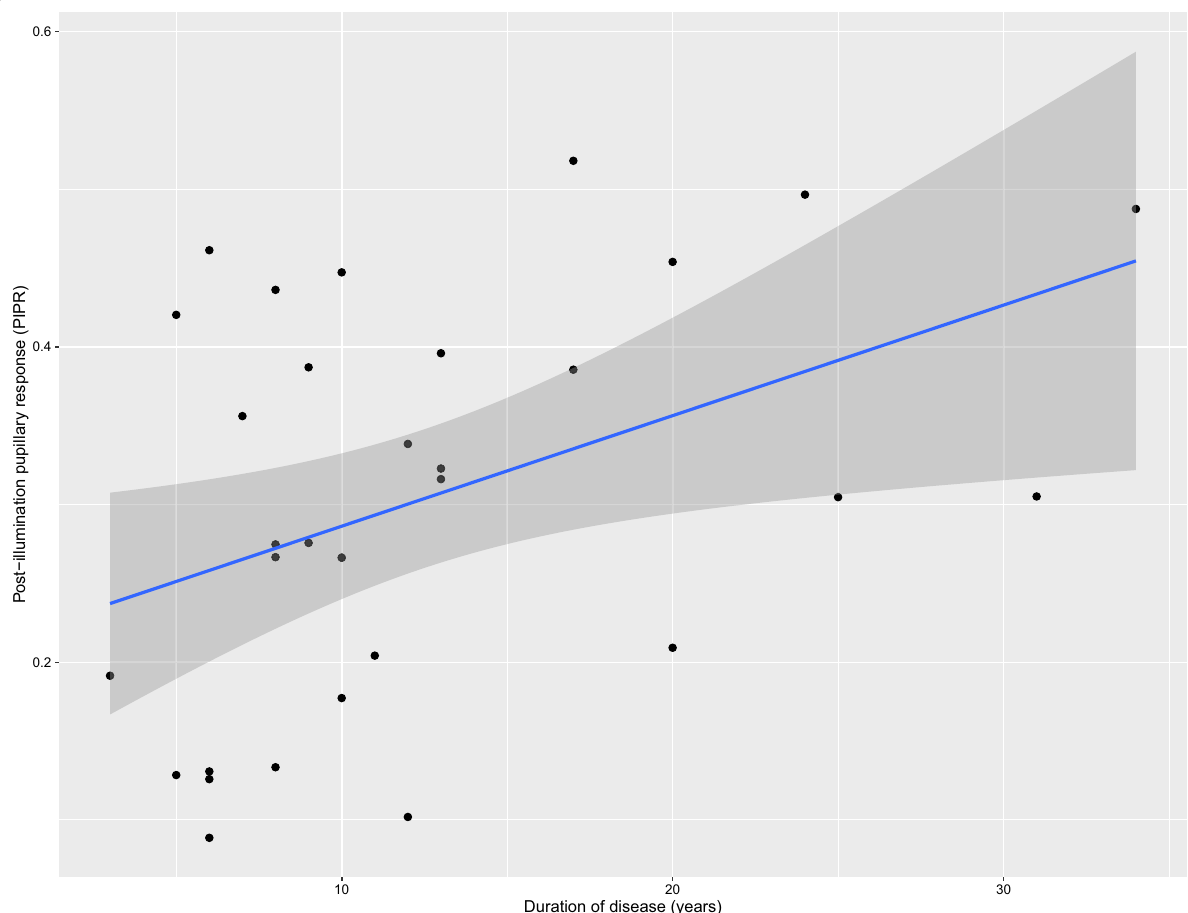
Fig. 2 The post‑illumination pupillary response to blue light (PIPR) as a function of illness duration (years since initial depression/mania/hypomania. A higher value indicates a greater post‑illumination contraction relative to baseline. The linear regression model predicts a 7% increase in the post‑illumination pupillary response to blue light for every 10‑year increase in disease duration, p =